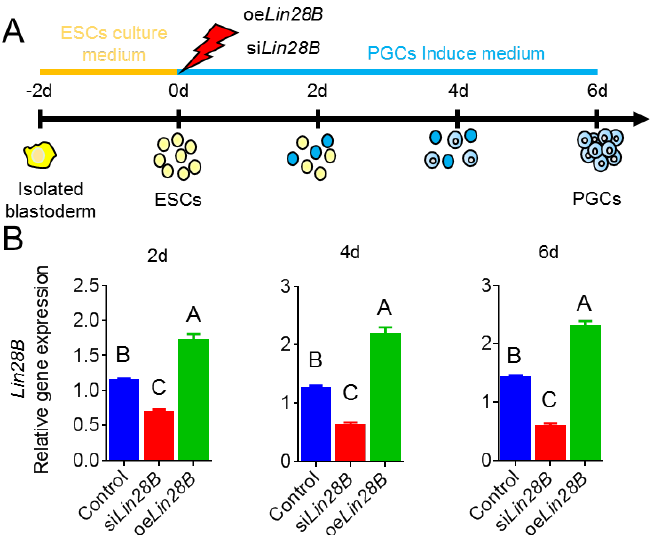
Figure 5. Lin28B could promote the formation of embryoid bodies(EBs) in BMP4-induced model in vitro. ( A ) Schematic diagram of illustrating the Lin28 B function via PGCs induction model in vitro. ( B ) Expression detection of Lin28B during the induction of PGCs. Different uppercase letters represent highly significant and the same letters represent no significant.